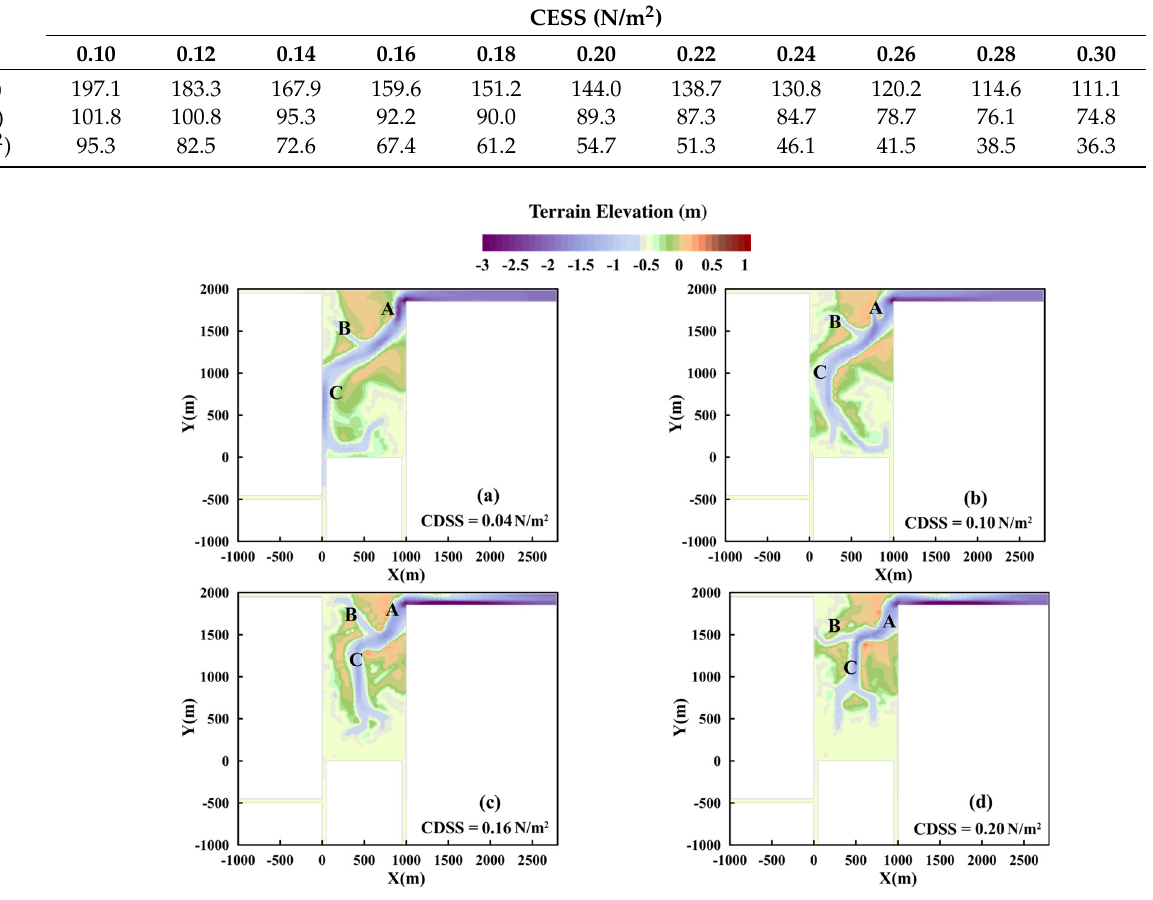
Table 1. Erosion amount (EA), deposition amount (DA), and net erosion amount (NEA) per unit area for different CESSs after 100 years.